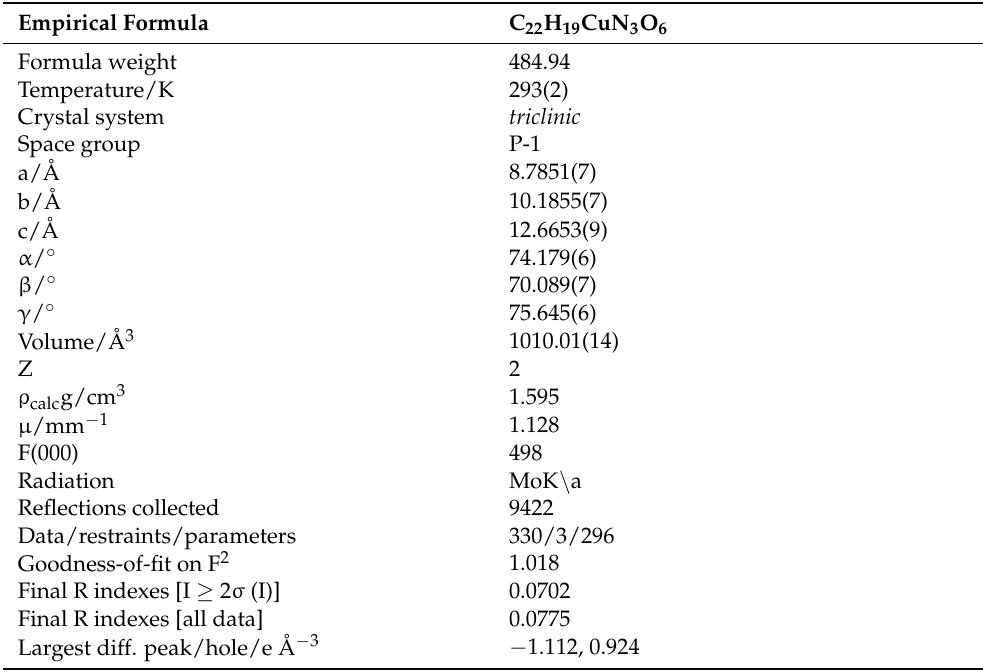
Table 1. Crystal data and structure refinement for compound ( 2